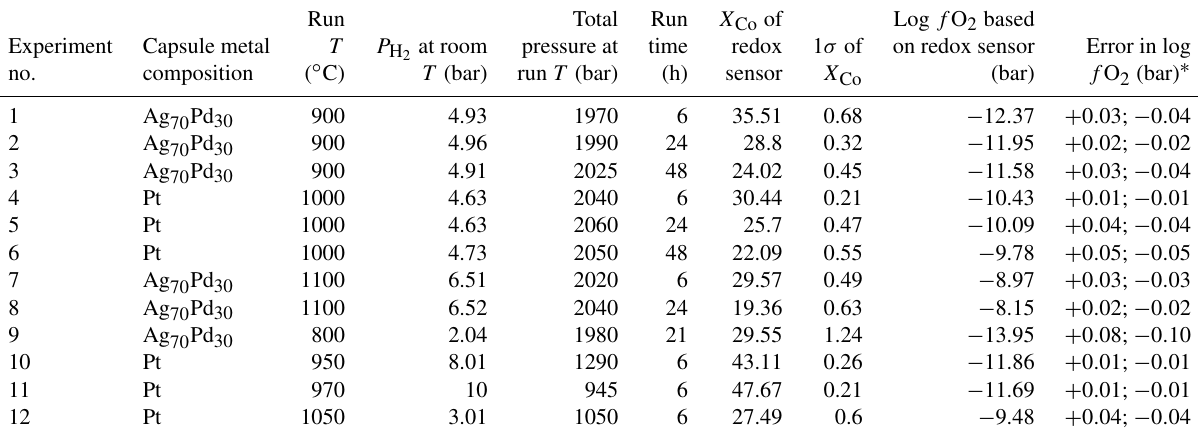
970 ∗ The uncertainty on the f O 2 values was derived by calculating the f O 2 for the mean measured X Co and the mean X Co ± 1 standard deviation of the mean value. This reflects a combination of analytical uncertainty and any true heterogeneity in the alloy compositions resulting from incomplete achievement of equilibrium.